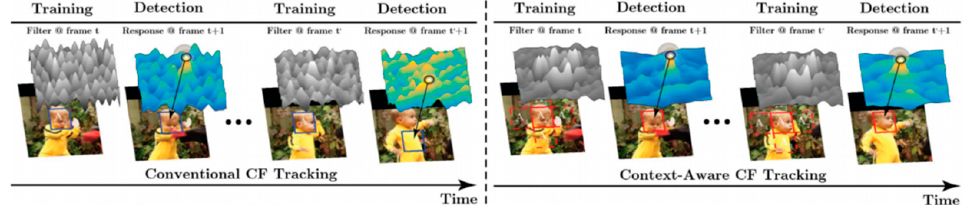
Figure 2. Comparing conventional CF tracking to proposed context-aware